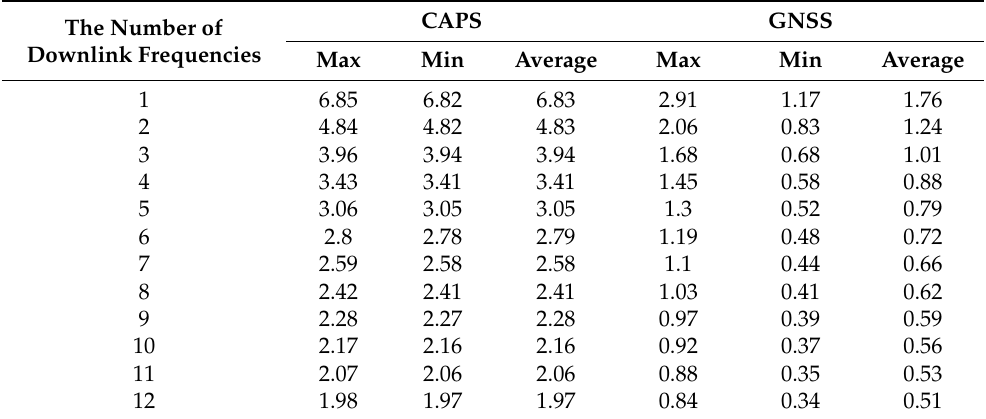
Table 2. Statistics of PDOP values of multi-frequency navigation signals in CAPS system and GNSS system.